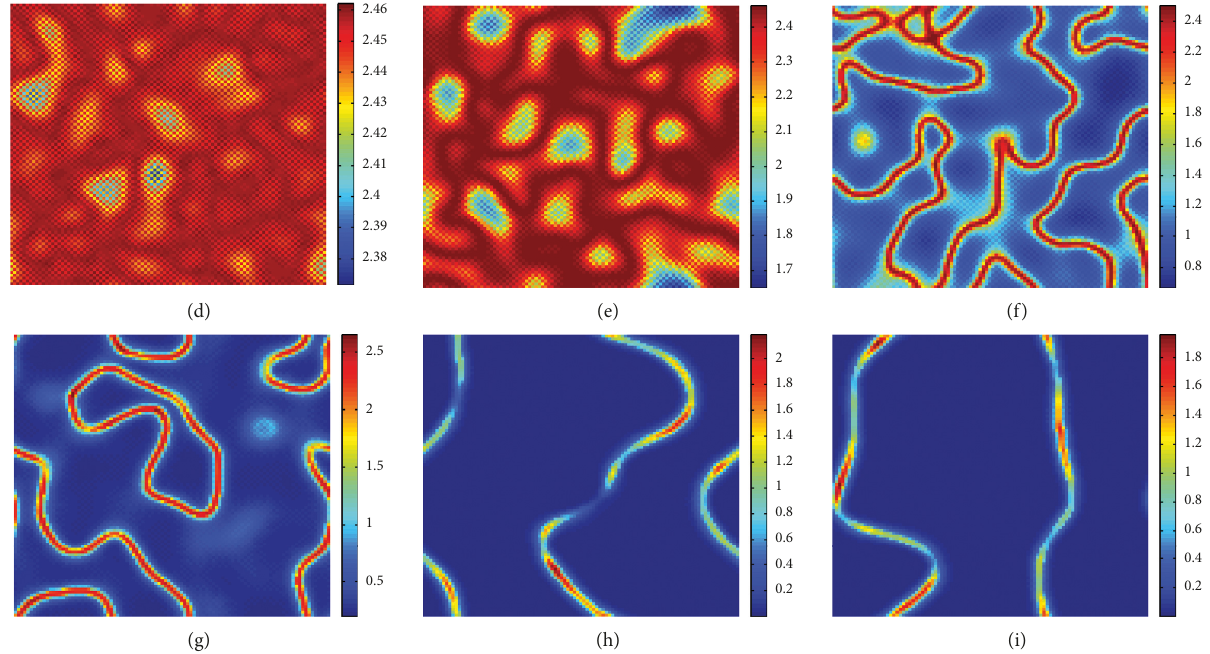
Figure 7: The formation of phytoplankton population spatial distribution pattern under certain diffusion parameters. Parameter values: I � 1 . 6, a � 0 . 5, b � 0 . 8, α � 0 . 7, e � 0 . 2, m � 0 . 45, d (d) t � 35; (e) t � 40; (f) t � 50; (g) t � 100; (h) t � 400; (i) t �